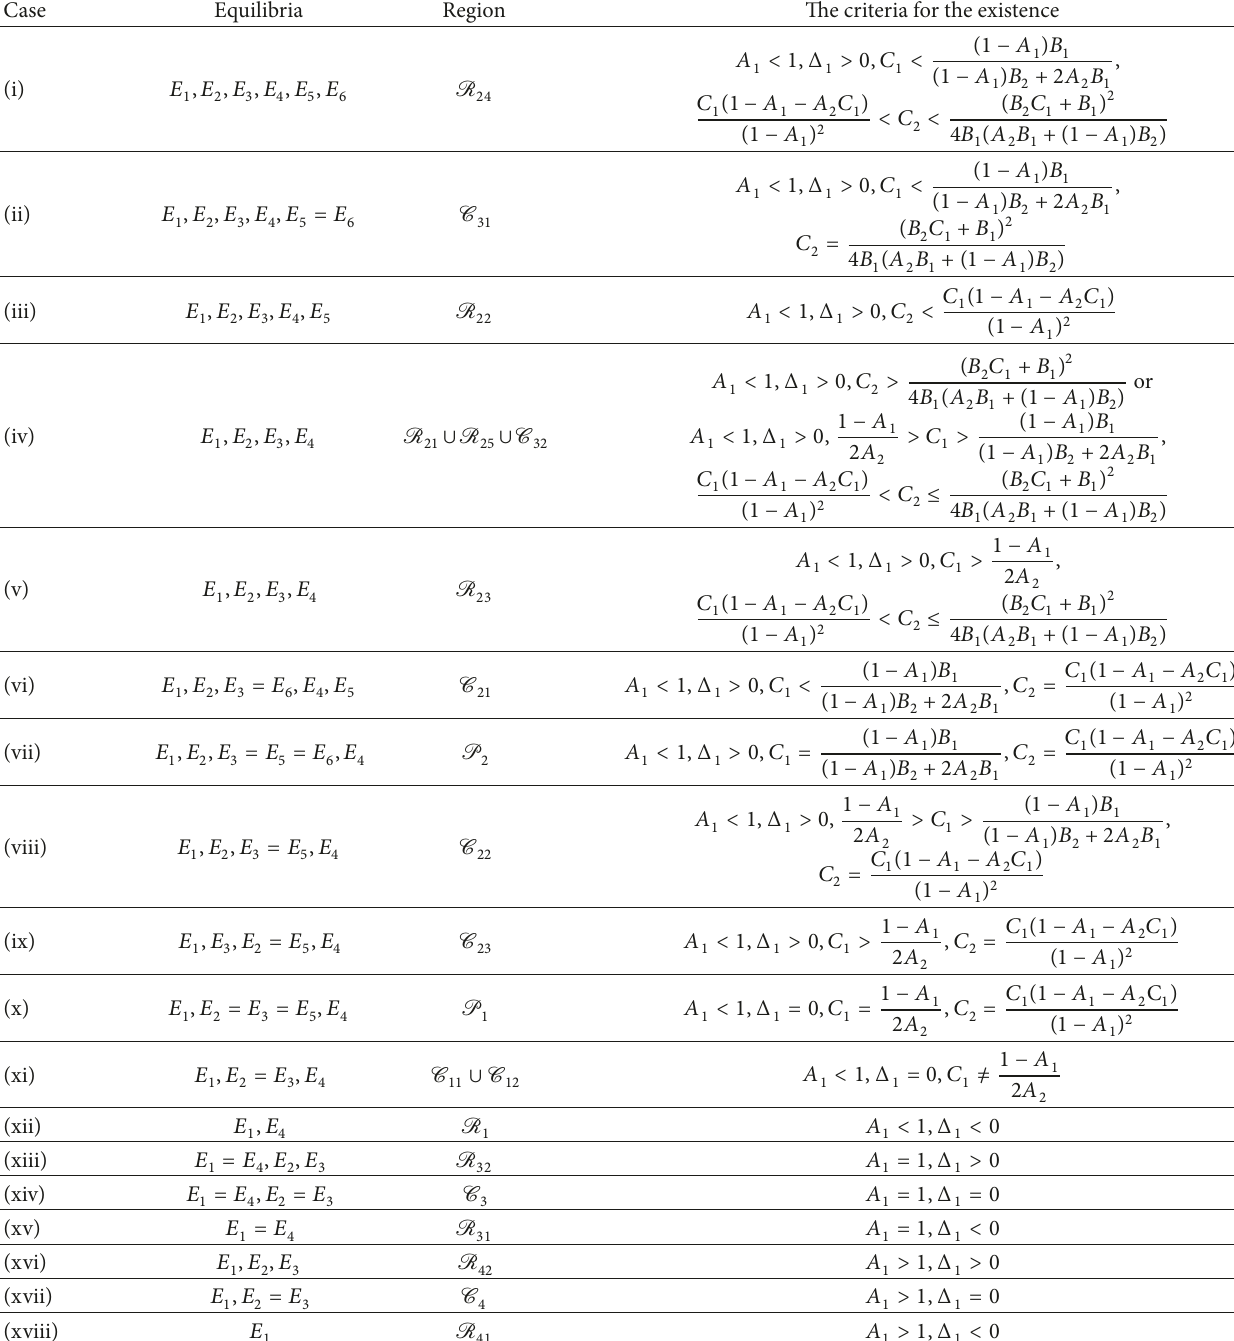
Table 1: The criteria for the existence of the equilibrium